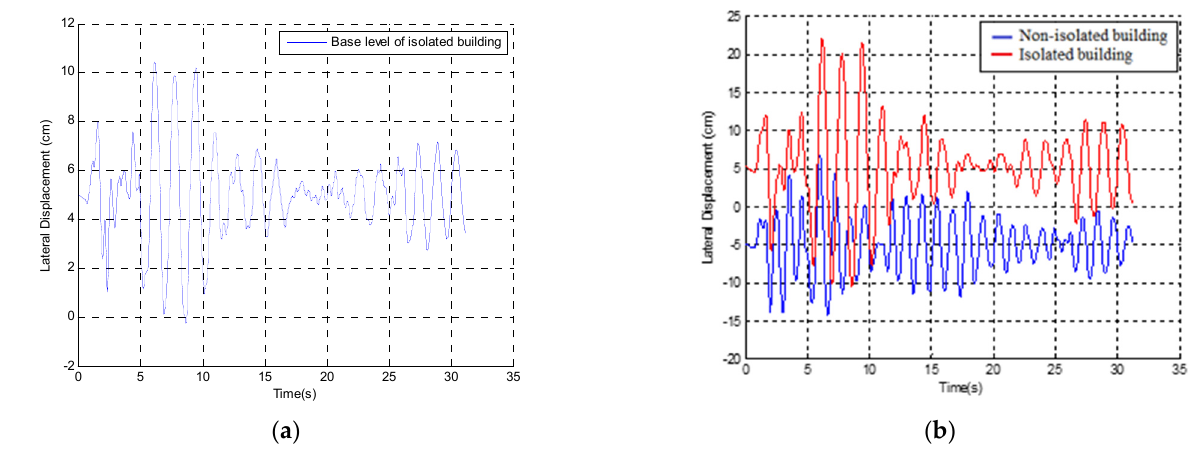
Figure 3. Lateral displacement time histories of a non ‐ isolated building and an isolated one: ( a ) base level; ( b ) top level.